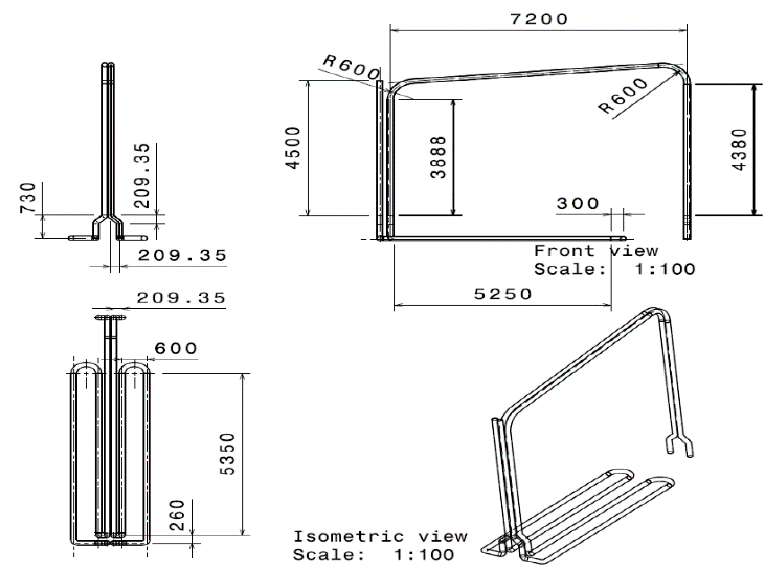
Figure 21. Pipe distribution and size. This image corresponds to the item named the steel tube in the cost table.